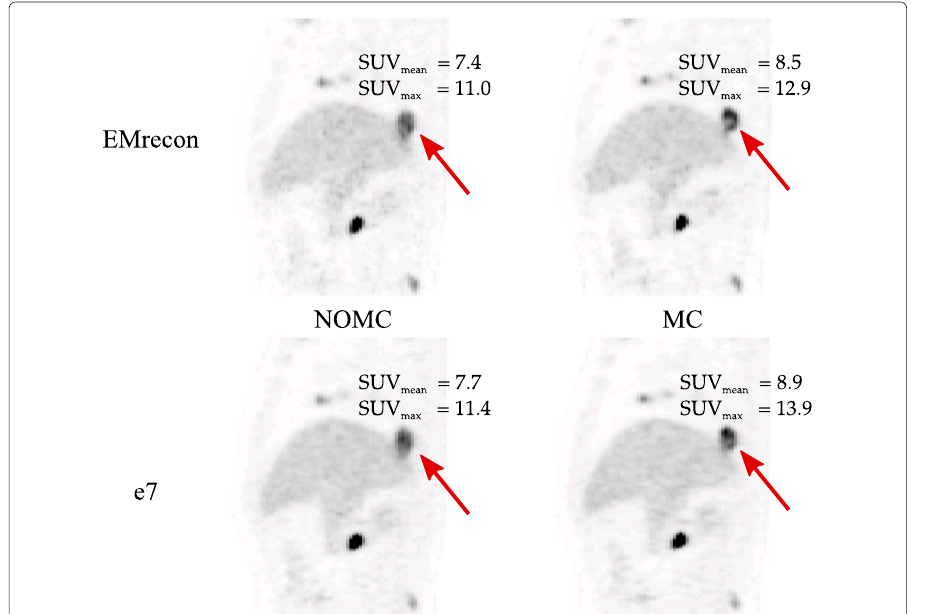
Fig. 7 Patient case #1 (sagittal plane) showing NOMC and MC reconstructions. The arrow highlights motion correction